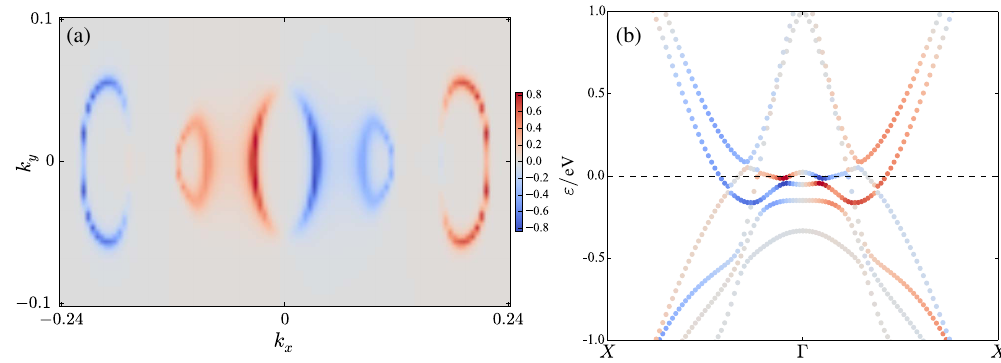
k ; ε FIG. 9. (a) Fermi-level dichroic signal [ D defined in the main text] for a WTe 2 bilayer. The Fermi surface has been broadened s ð F Þ with a Lorentzian with a full width at half maximum of 10 meV. The Fermi pocket around Γ [38,62,63] does not encircle a massive Dirac k ; E Þ for the band structure along X Γ X for energies near the Fermi fermion. (b) D s ð